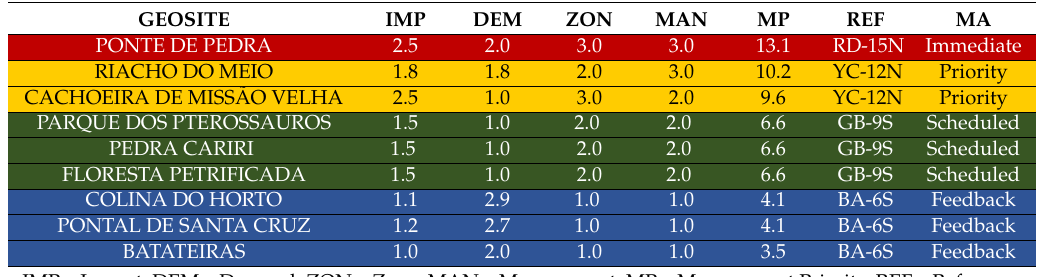
chart in Figure 2. The results for the Ponte de Pedra geosite were high impact, medium demand, fragile zone and passive management, and the recommendation was “immediate management